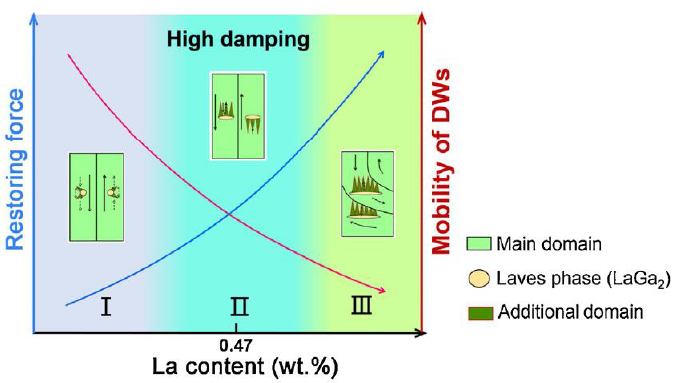
Figure 16. Schematic of the high damping mechanism of Fe–21Ga alloy with proper La doping